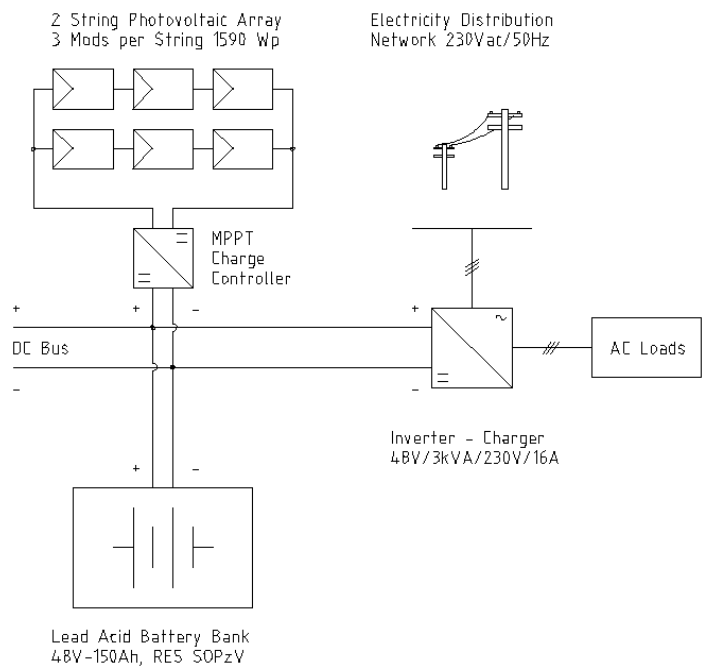
Figure 1. The diagram of the photovoltaics and lead-acid batteries (PV-BAT) system.